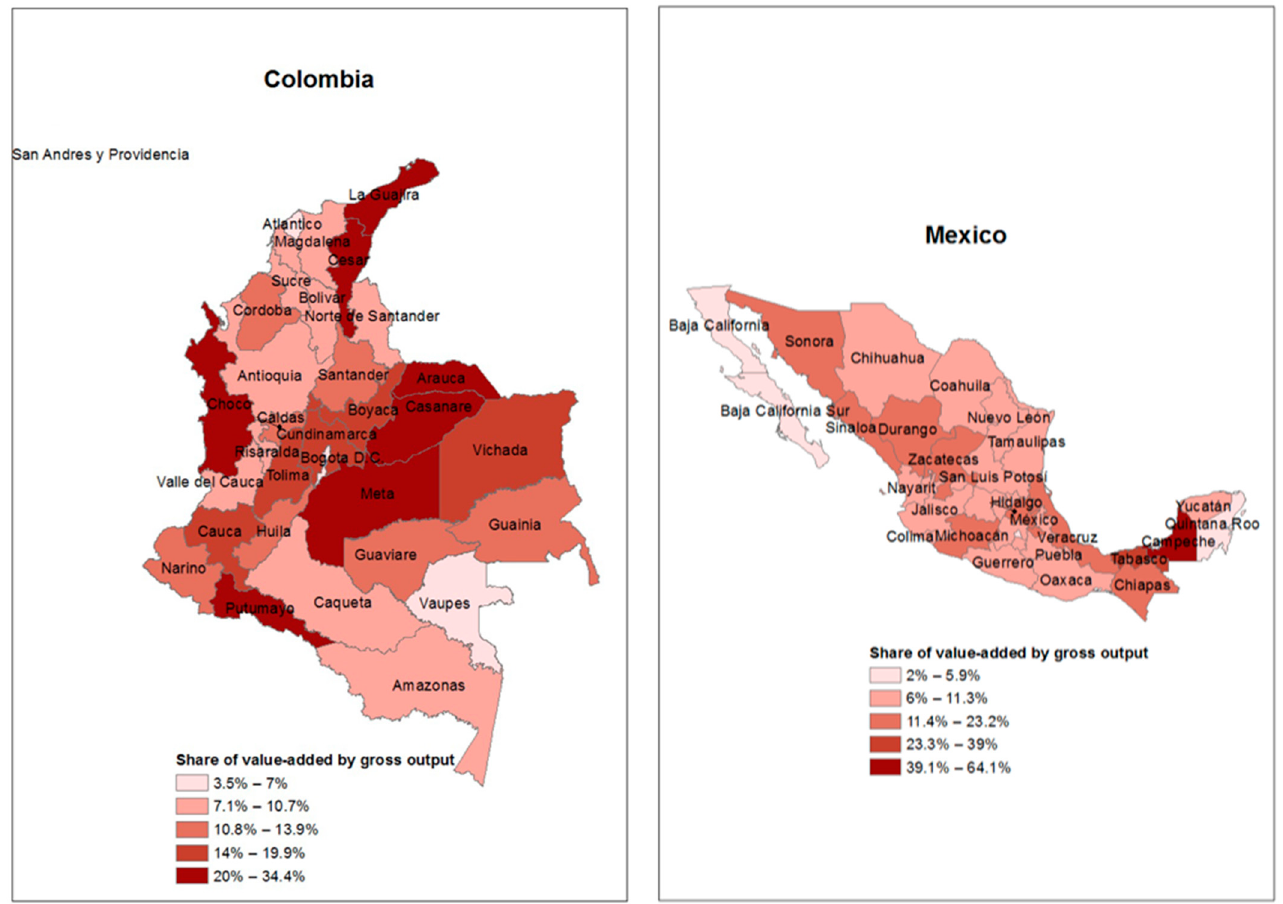
Figure 1. Value-added share of resource-based industries in total gross regional output. Note: The maps of the four analyzed countries are presented, with the regional aggregation adopted in the study. The upper left map refers to the Brazilian states, the upper right to the Chilean regions, the lower left to the Colombian departments, and the lower right to the Mexican states.